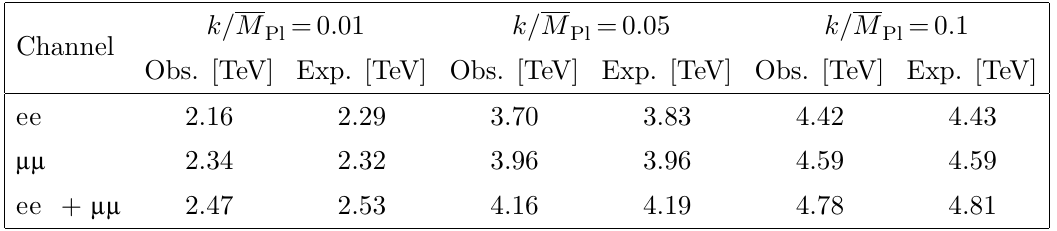
Table 6 . The observed and expected 95% CL lower limits on the masses of spin-2 resonances for widths equal to 0.01, 0.36, and 1.42%, corresponding to coupling parameters k/M and